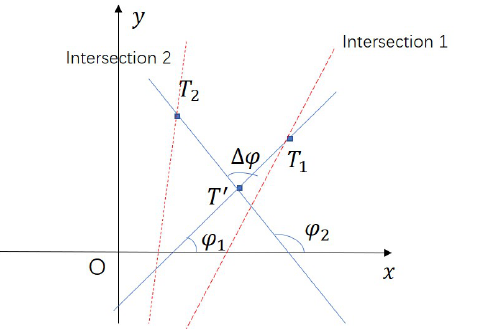
Figure 5. Top view of ground